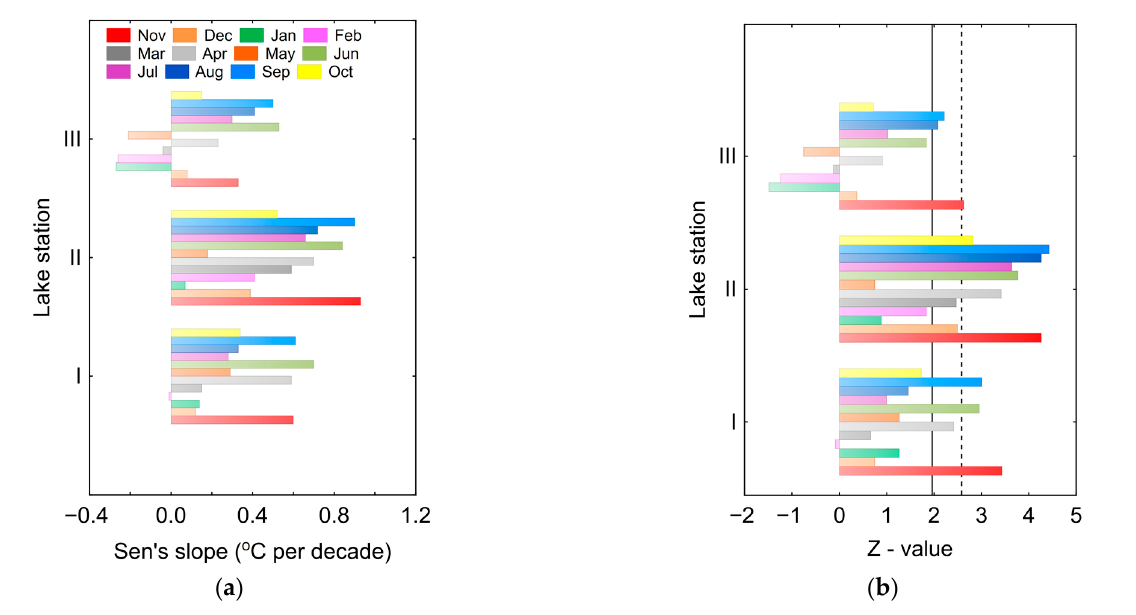
Figure 5. Changes in mean monthly lake water temperatures: ( a ) Rate of changes in °C per decade and ( b ) significance of the changes (solid line—significance level of 0.05, dashed line—significance level of 0.01).